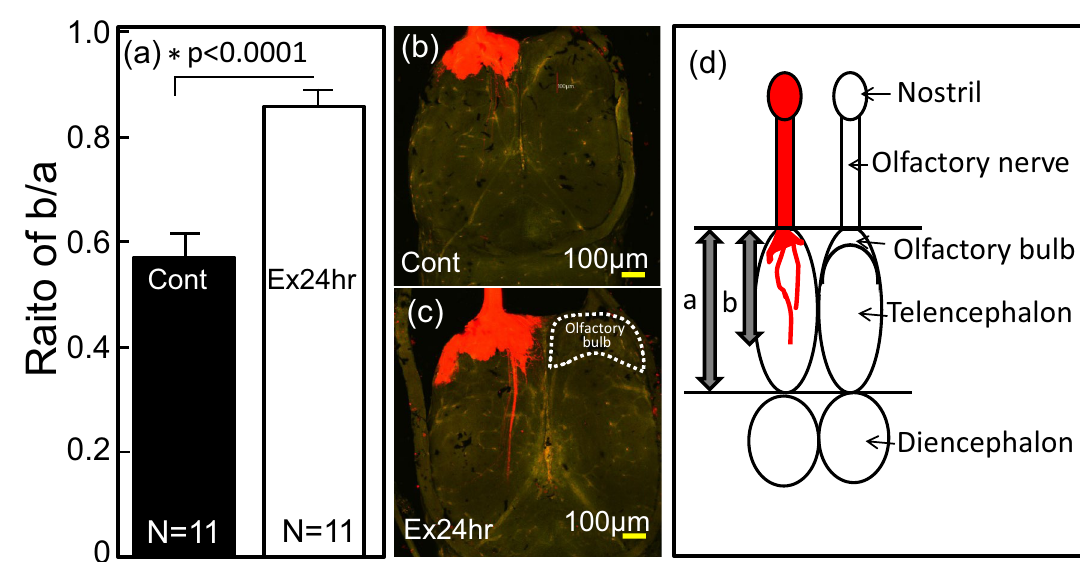
Figure 7. In situ-hybridization in the Xenopus lavies brain, using probes for selected genes. Xenopus laevis tadpoles sampled from Ex 6 hr (6 h exposure to predation), Ex 24 hr (24 h exposure to predations), Ex 10 days (10 days exposure to predation), and Ex 5 days-Out (5 days exposure to predation and then five days without) were used for in situ-hybridization using selected genes. (a) The red rectangle indicates the region of the brain used in this experiment. (b) Magnified image of the brain and the names of the brain regions. Tc, Dc, Ms, and Mt indicate the telencephalon, diencephalon, mesencephalon, and metencephalon, respectively. Antisense and sense probes were hybridized to the brain. In situ-hybridization results using anti-sense and sense probe for non-NMDA glutamate receptor (c) , myosin light chain (d) , hypoxia-inducible factor 1 alpha (e) , erythropoietin receptor (f) , and serpin 1 mRNA binding protein 1 (g) . ① corresponds to the mammalian isocortex; ② indicates a ventral region of the posterior commissure, which may correspond to the subcommissural organ; ③ and ④ indicate the thalamus and hypothalamus in the diencephalon, respectively.